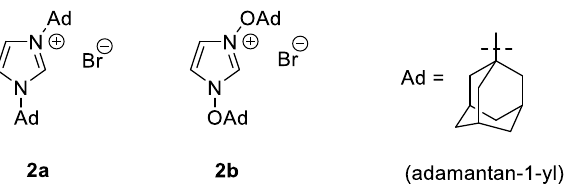
Figure 2. The structure of N -adamantanyl- functionalized ‘Arduengo salt’ 2a and its bis-oxidized analogue, 2b .